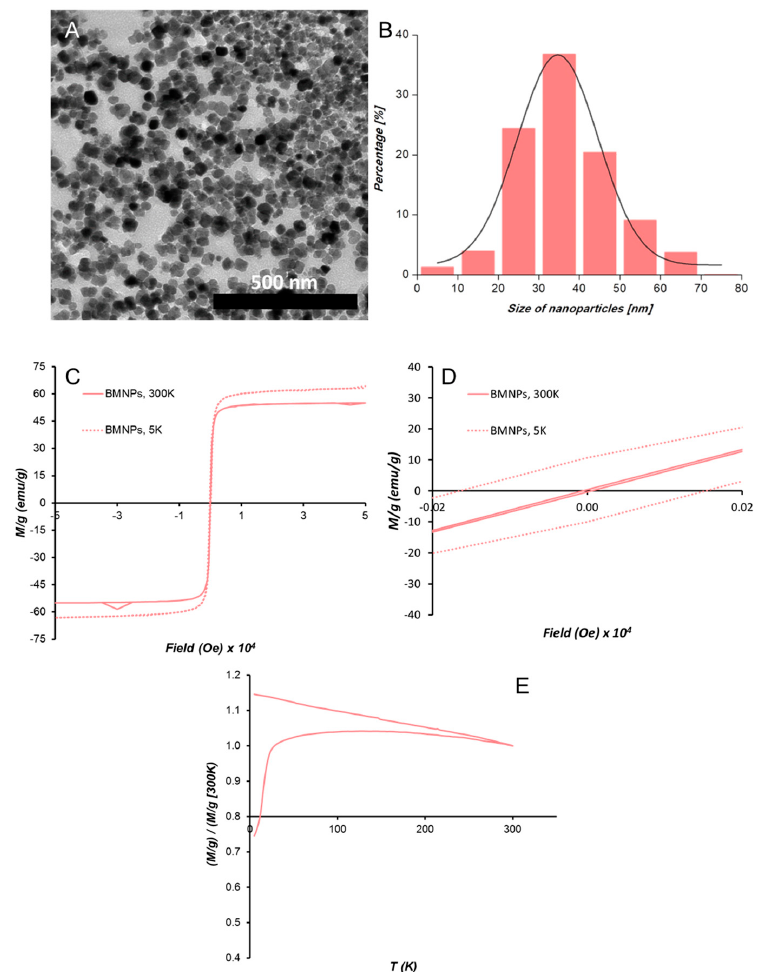
Figure 2. Biomimetic magnetic nanoparticles (BMNPs) characterization. ( A ) TEM image of BMNPs and ( B ) crystal size distribution. ( C ) Hysteresis cycle of BMNPs at 300 K and 5 K. ( D ) Detail of the hysteresis cycle in the absence of external magnetic field at 300 K and 5 K. ( E ) Zero field cooling-field cooling (ZFC-FC) curves of BMNPs.